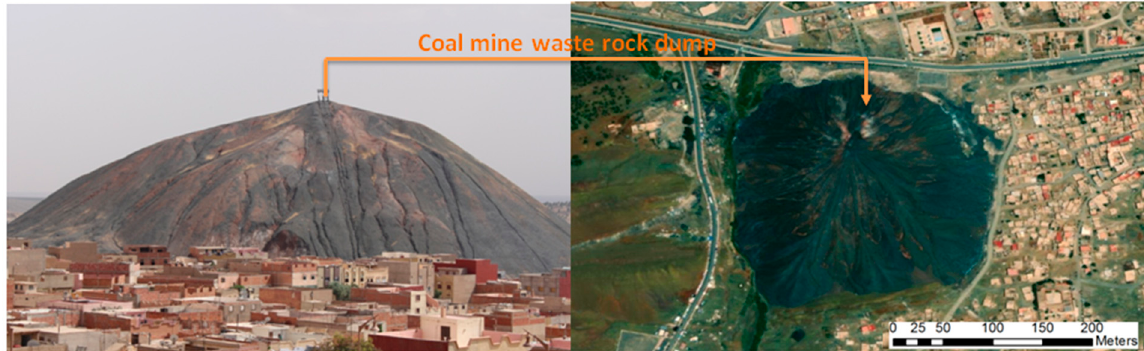
Figure 2. Coal mine waste rock dump in the Jerada city.